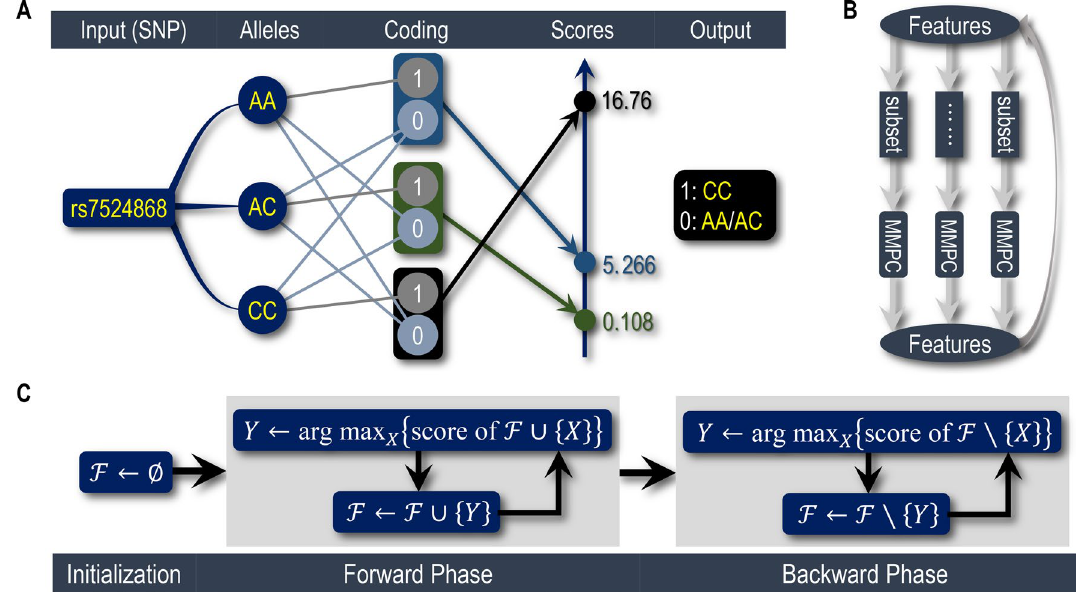
Figure 1. Main idea of building precise diagnostic models. ( A ) An illustration on how Snp2Bin works, taking the SNP, rs7524868 of phs000634, for example. Here, the score of a coding-scheme is defined as the χ 2 -statistic of the corresponding contingency table. ( B ) Schematic of IterMMPC . ( C ) Pseudocode for OptNBC , which consists of forward and backward phases.